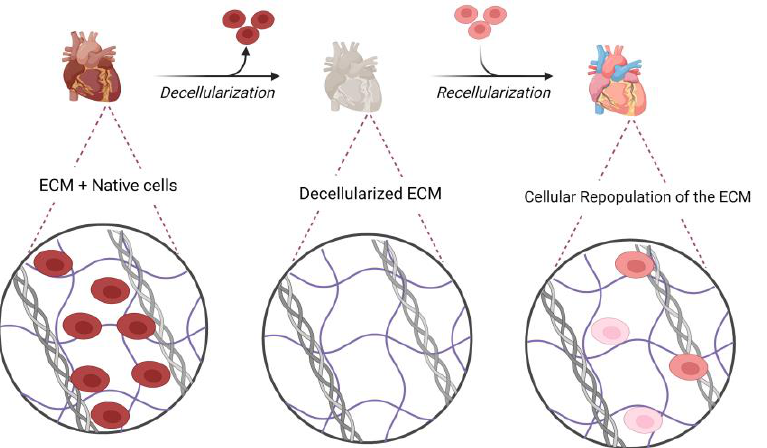
Figure 1. The impact of decellularization and recellularization protocols on cardiac extracellular matrix.